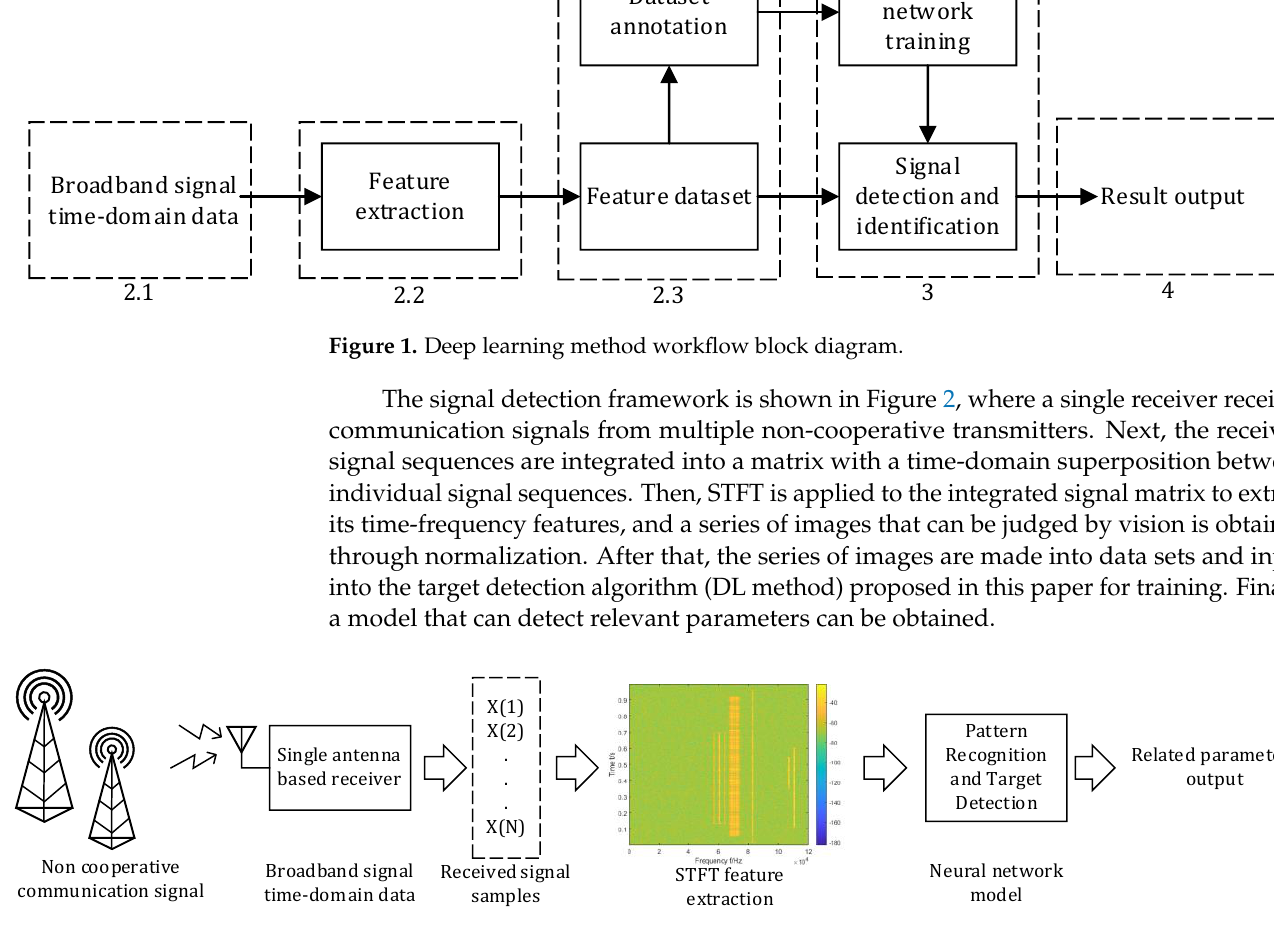
Figure 2. The paper deep learning signal detection framework.